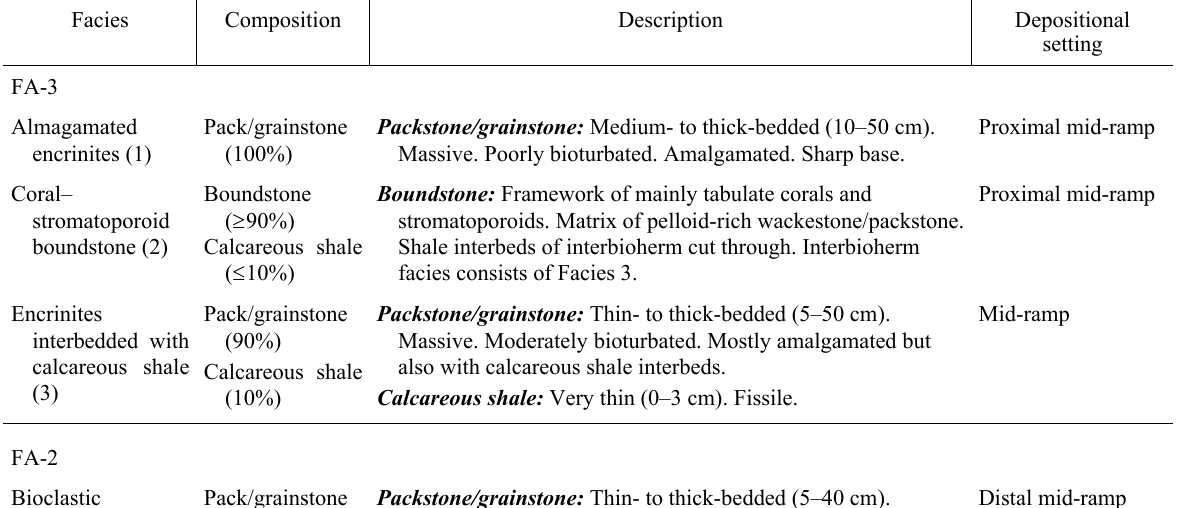
Boundstone: Framework of mainly tabulate corals